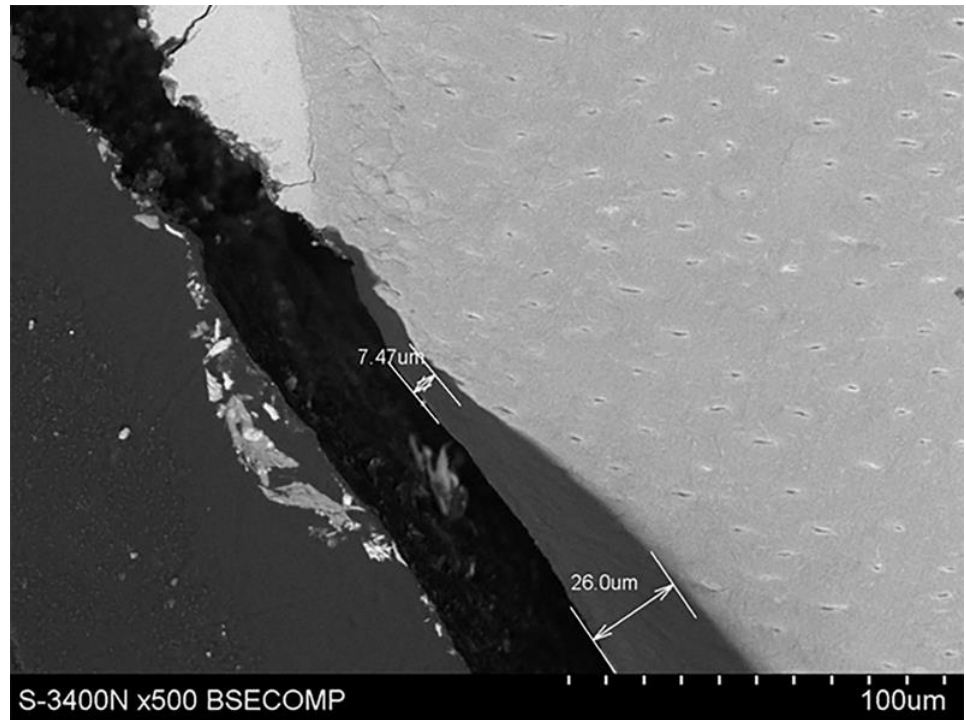
Figure 4. Scanning electron microscope image showing the thickness of root cement in the cervical region.